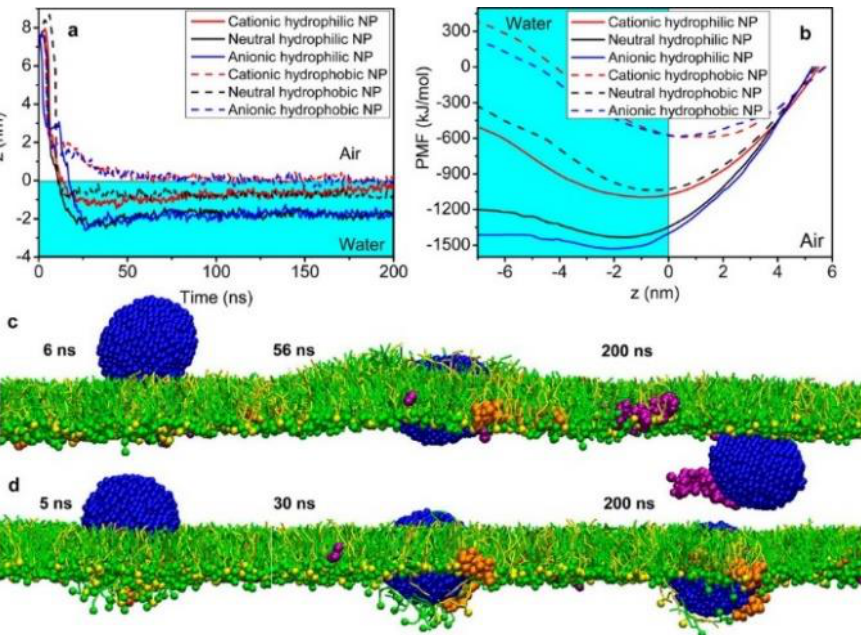
Figure 10. Calculations of PMFs for the interaction between NP and pulmonary surfactant monolayer ( a , b ) and snapshots from simulations of differently charged NPs interacting pulmonary surfactant proteins (SP-B1-25 and SP-C) and phospholipid monolayer ( c , d ). Reproduced with permission from [63], American Chemical Society, 2013.